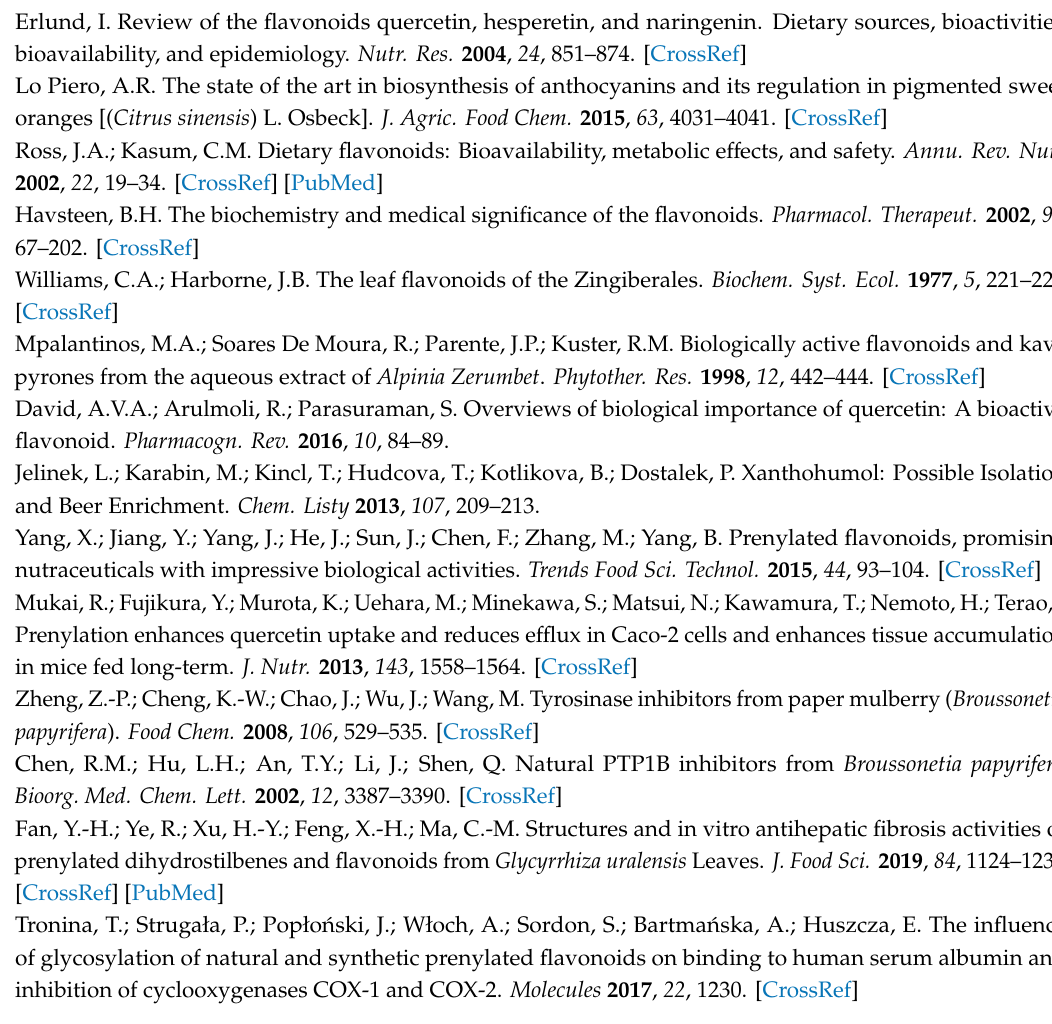
1 – 9 , Figure S27–S33: HRESIMS spectra of compounds 2 – 9 , Table S1: Microbial screening results, Table S2: